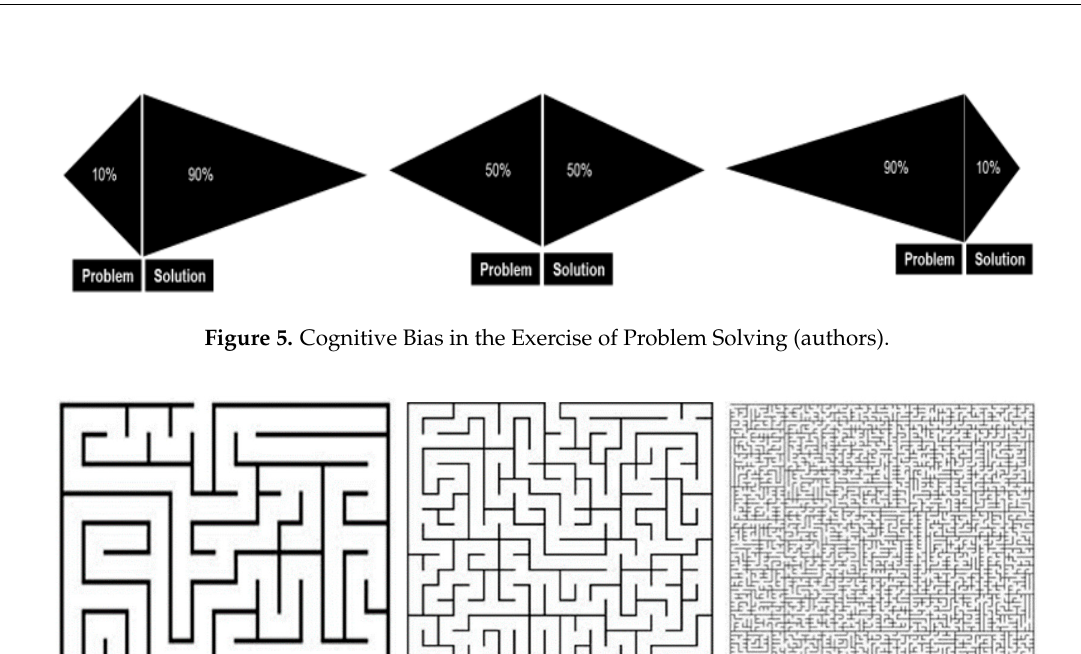
Figure 6. Illustrative example of Cognitive-Bias in Problem Solving (authors).